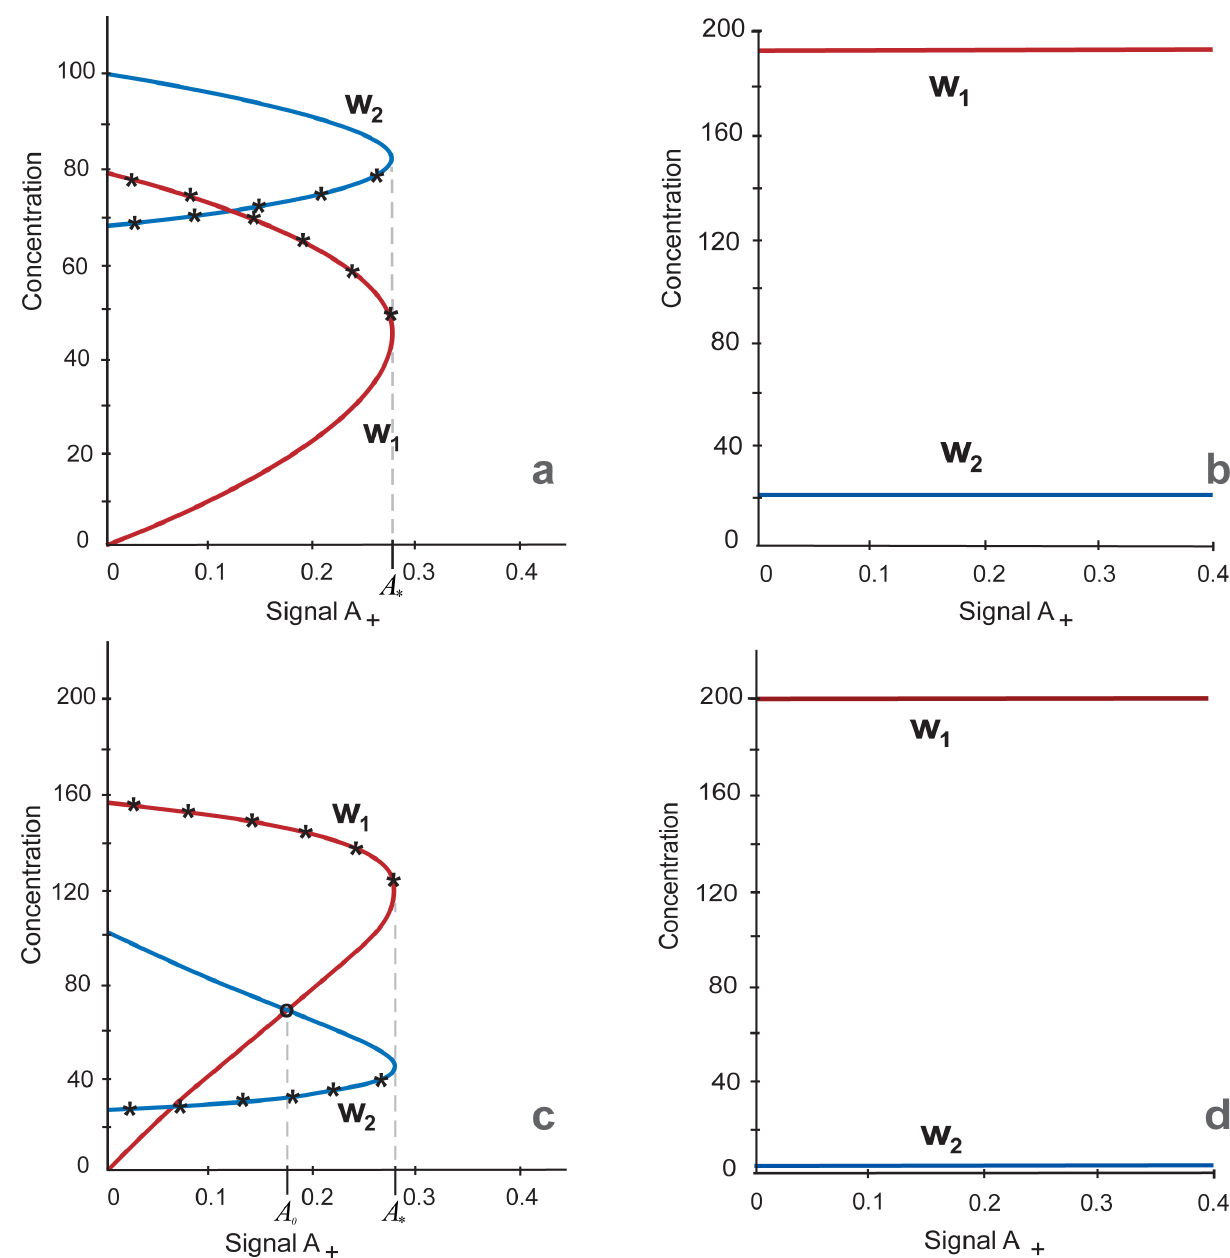
Fig 2. Multiplicity of stationary solutions representing as w and w dependence on the parameter A , 0 (cid:20) A (cid:20) 0 . 4 at h = 6 (2a and 2b) and h = 2 (2c 1 2 and 2d). a. Initial steady state values w 2 > w 1 and A = 0 simulate differentiation state. The w 1 /w 2 ratio while A is growing upon A = A (cid:3) = 0 . 277 (the turning point), corresponds to the differentiation steady state. Asterisks indicate arcs of the graphs with unstable solutions. b. Initial steady state values w 1 > w 2 and A > A (cid:3) simulate the pluripotent state. The graph of the steady state while decreasing A upon A (cid:21) 0 (including the range 0 (cid:20) A < A (cid:3) ) is depicted. Both Fig 2A and 2B show that three states (two stable and one unstable) exist in the range 0 (cid:20) A < A (cid:3) = 0 . 277 ,while there is one steady state, when A > A (cid:3) . c. Stationary solution with initial steady state values w > w and A = 0 corresponding to the differentiated cell. w and w variables have turning points at A 2 1 1 2 = A (cid:3) . Asterisks indicate unstable solutions. d. Stationary solution with initial steady state values corresponding to the pluripotent cell. The Fig 2C and 2D shows that three states (two are stables and one is unstable) exist in the range 0 (cid:20) A < A (cid:3) = 0 . 277 ,while there is one steady state, when A > A (cid:3) and this is the pluripotent state